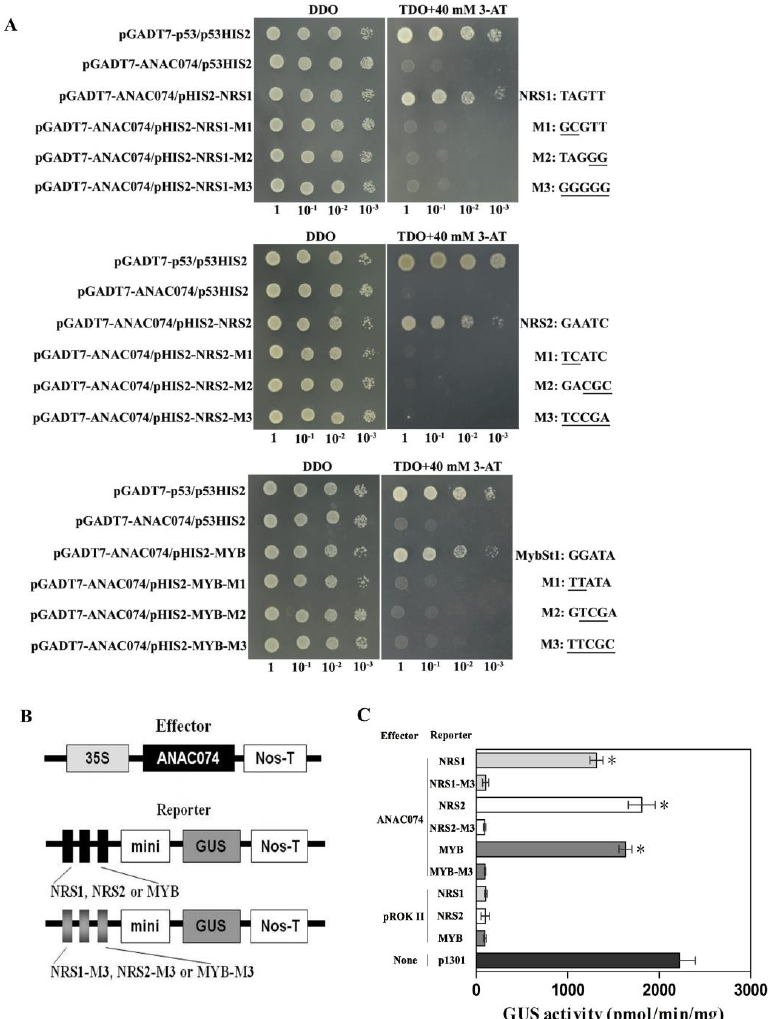
Figure 2. The bindings of NRS1, NRS2 and MybSt1 to ANAC074. ( A ) Analysis of the specific bindings of NRS1, NRS2, and MybSt1 to ANAC074 using Y1H assay. The right panel showed the sequences of NRS1, NRS2, MybSt1 motifs and their respective mutants (M1, M2 and M3). Positive transformants were confirmed by spotting yeast cells with serial dilutions (1/1, 1/10, 1/100, 1/1000) onto medium of SD/-His/-Leu/-Trp with 40 mM 3-AT. Positive control: pGADT7-p53 interacting with p53HIS2; Negative control: pGADT7-ANAC074 interacting with p53HIS2. The transformants grown at SD/-Leu/-Trp were used as positive controls for transformant growth. ( B ) Schematic diagram of the reporter and effector vectors. The effector was constructed by cloning the ORF of ANAC074 into pROKII under 35SCAMV promoter. Three tandem copies of NRS1, NRS2, and MybSt1 (black shading) or their complete mutant types NRS1-M3, NRS2-M3, and MYB-M3 (grey shading) were respectively fused to the minimal 35S promoter for driving GUS as reporter vectors. ( C ) Transient co-transformation of effector and reporter constructs into tobacco leaves to study the specific bindings of NRS1, NRS2, and MybSt1 to ANAC074. GUS activity was determined to study the binding affinity between the test DNA sequence and ANAC074, and the combinations between effector and reporter construct are shown in the left panel. The empty pCAMBIA1301 was as positive control. Co-transformed empty pROKII with pCAM-NRS1, pCAM-NRS2 or pCAM-MYB were as negative controls. Data represent mean values of three independent experiments, and bars indicate standard deviation (SD). Asterisks indicate a significant difference compared with the mutation (Student’s test; * p